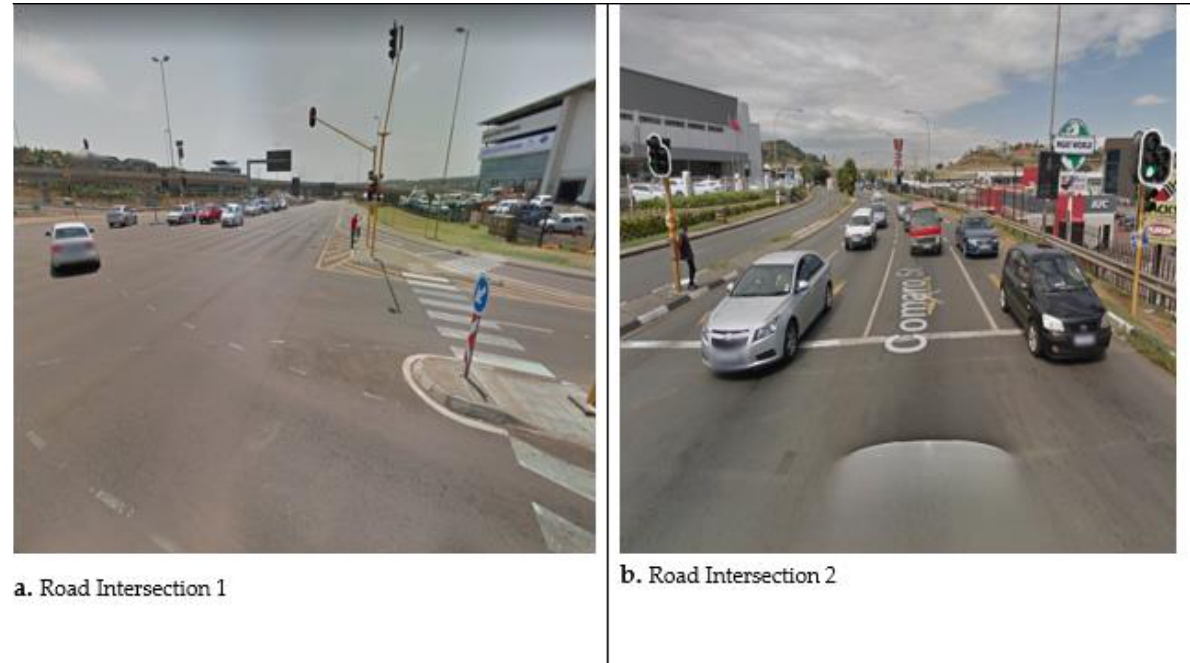
6 of 24 Table 1. Features of the Signalized Road Intersections. Road Intersections